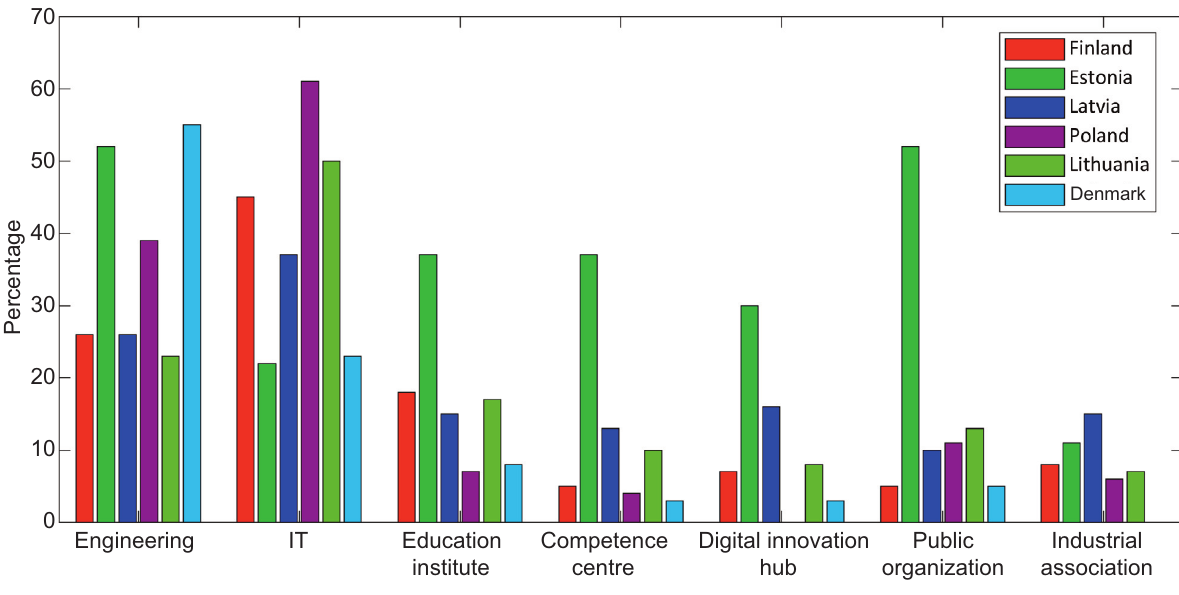
Fig. 1. Distribution of manufacturing relevant entities in each country. One entity having divisions in different fields means that totals may add up to over